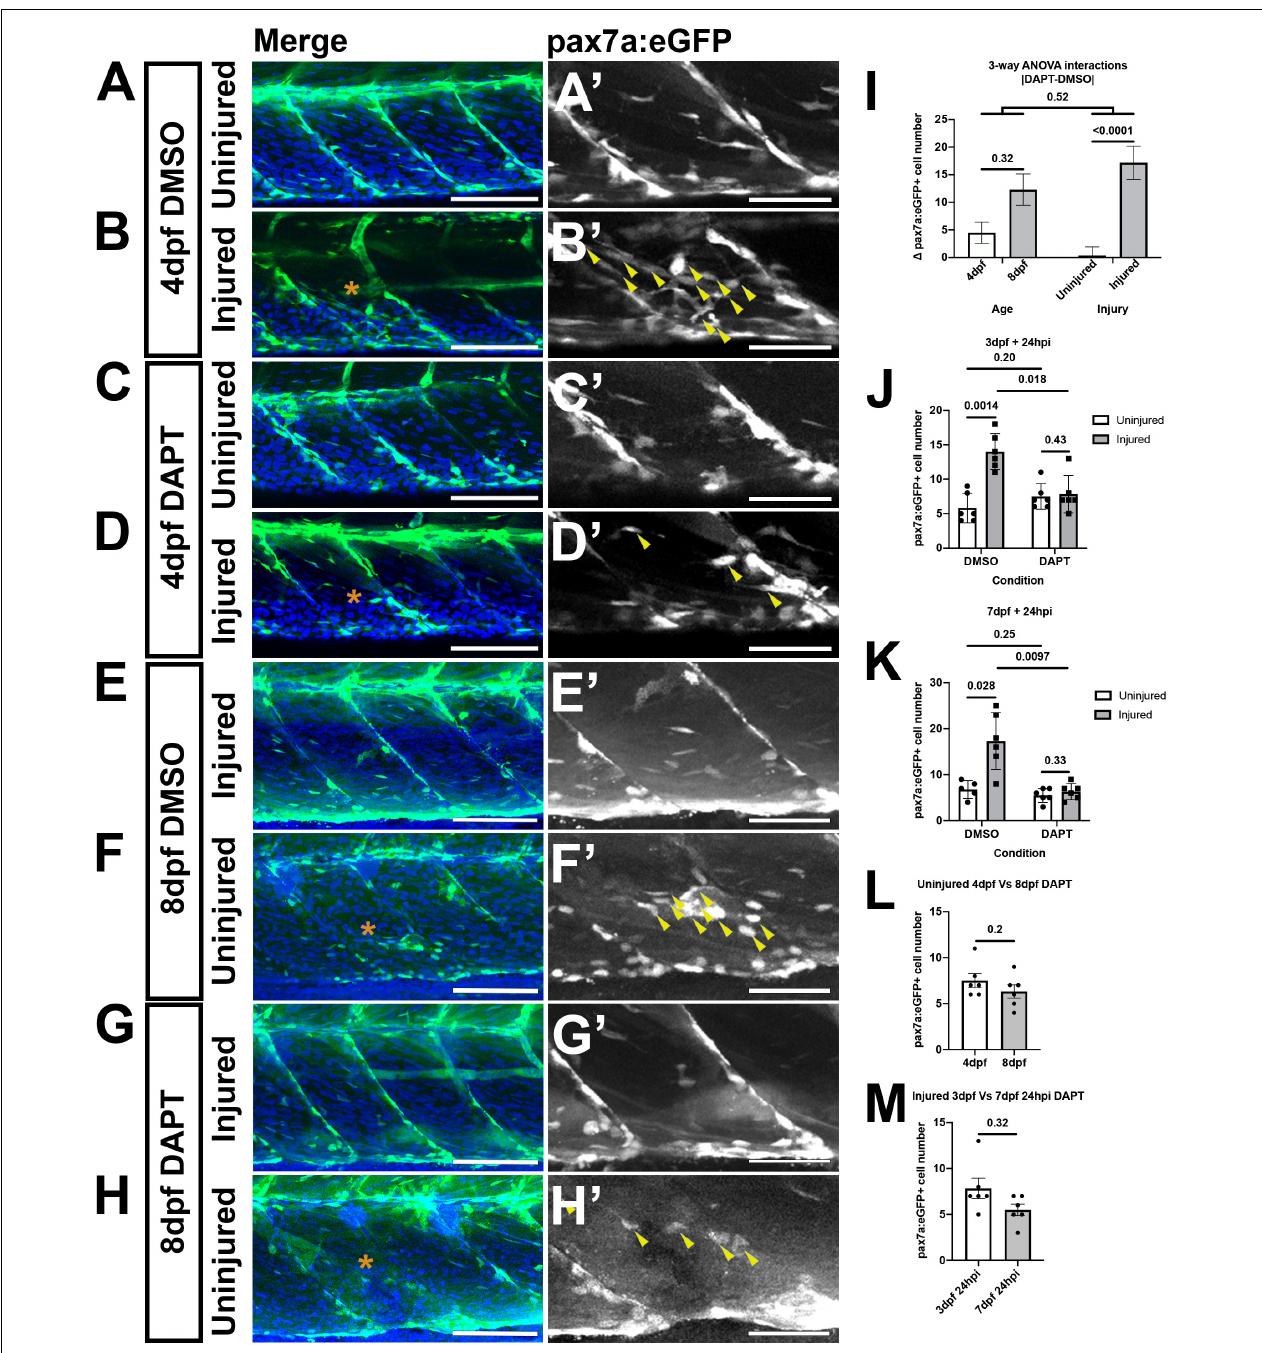
FIGURE 4 | A loss of Notch activity attenuates the muSC response to injury. Projections of confocal stacks of the myotome in uninjured (A,C,E,G) and injured (B,D,F,H) pax7a:eGFP larvae at 3 dpf (A–D) or 7 dpf (E–H) . Animals were treated with 1% v/v DMSO (A,B,E,F) or 100 µ M DAPT (C,D,G,H) prior to and after injury, fixed at 24 hpi and nuclei labeled with DAPI. There are more muSCs expressing eGFP (arrowheads) recruited to the injury (asterisk) in DMSO treated larvae (B’,F’) compared to DAPT treated larvae (D’,H’) . Quantification of pax7a:egfp-expressing muSCs in uninjured and injured 3 and 7 dpf larvae treated with DMSO or DAPT. Tests for significant differences in muSC number due to injury, DAPT or age revealed that injury affected the number of muSCs present ( p < 0.05), but DAPT treatment nor developmental stage did ( p > 0.05, I ). Pairwise comparisons revealed that injury-induced changes to the number of muSCs is attenuated by treatment with DAPT ( p < 0.05, J,K ). There is no significant difference in the number of muSCs in the myotome of uninjured 4 and 8 dpf larvae treated with DAPT ( p > 0.05, L ). Likewise, there is no difference of muSC number in the myotome of injured 4 and 8 dpf larvae treated with DAPT ( p > 0.05, M ). Significant differences were tested by 3-way ANOVA following transformation by ART ( n = 47) and post hoc tests performed using a Dunn’s test with Benjamini and Hochberg correction. Error bars represent standard deviation, and values above comparison bars represent significance ( p -values). Scale bars: 100 µ m (A–H) , 50 µ m (A’–H’) .